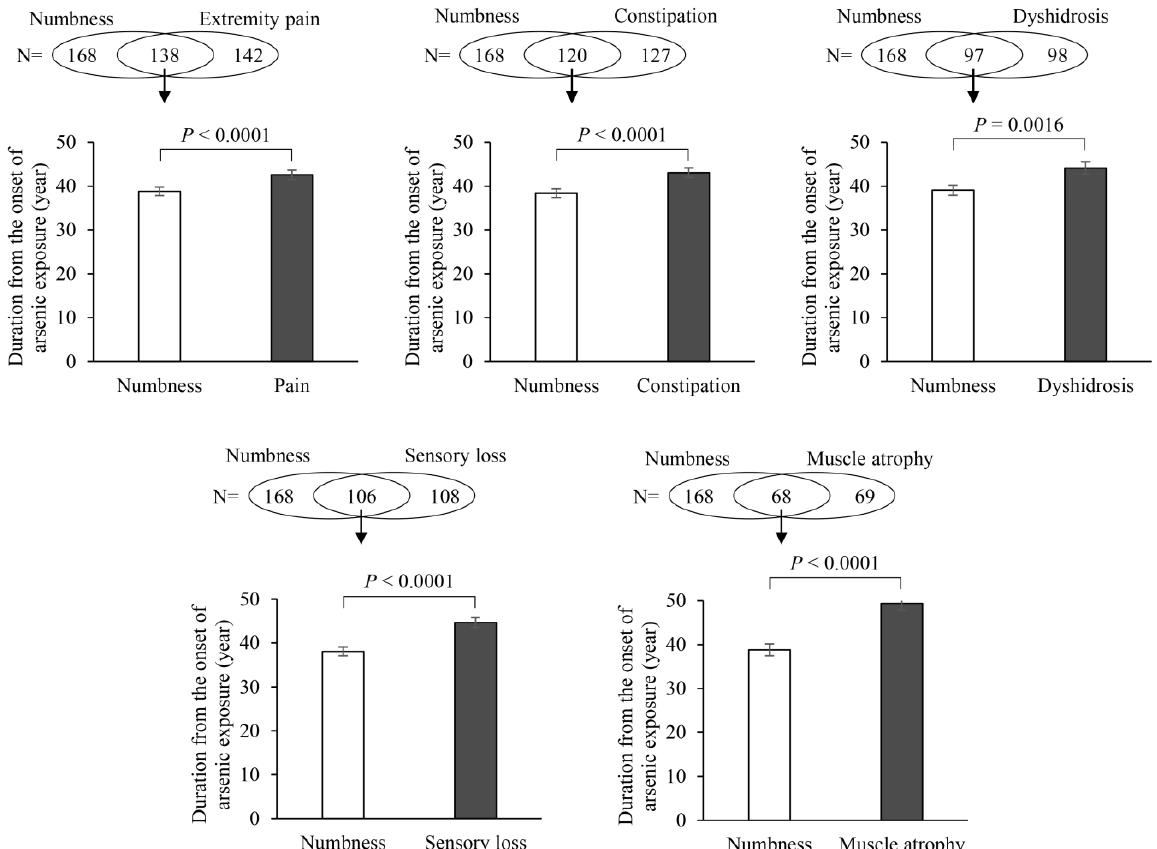
Figure 2. Differences in the duration from initial exposure to symptom onset between numbness and other neurological symptoms were analyzed with the paired t -test in participants with numbness and at least one other neurological symptom. We confirmed that extremity numbness was the earliest subjective neurological symptom. Bar graphs are presented as mean ± SEM.